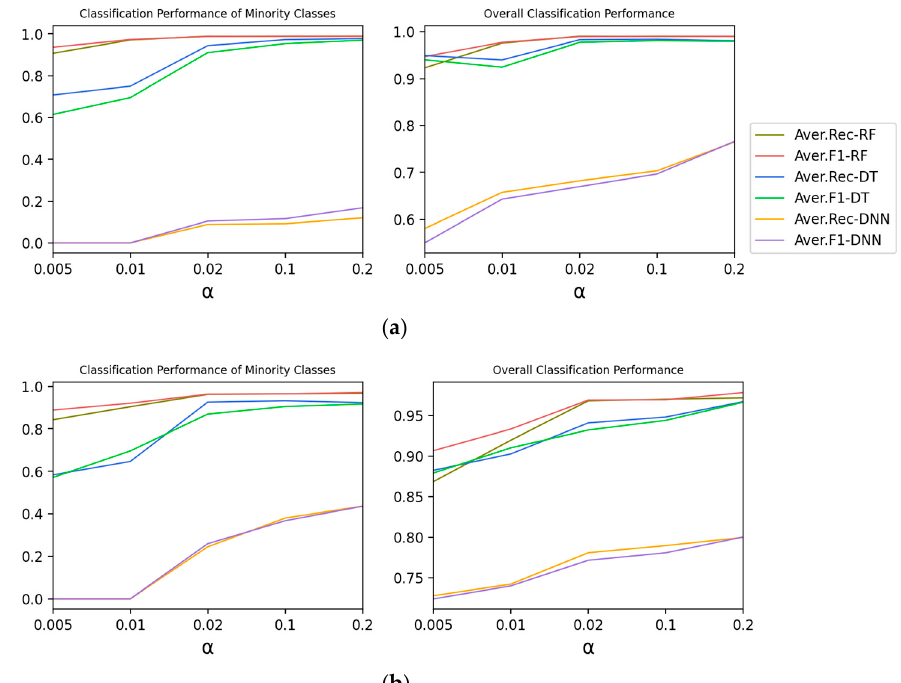
α Figure 5. The effect of α on the classification performance of Type 2. ( a ) Moore Dataset; ( b ) CICIDS on the classification performance of Type 2. ( a ) Moore Dataset; ( b ) CI- Figure 5. The effect of 2017 Dataset. CIDS 2017 Dataset